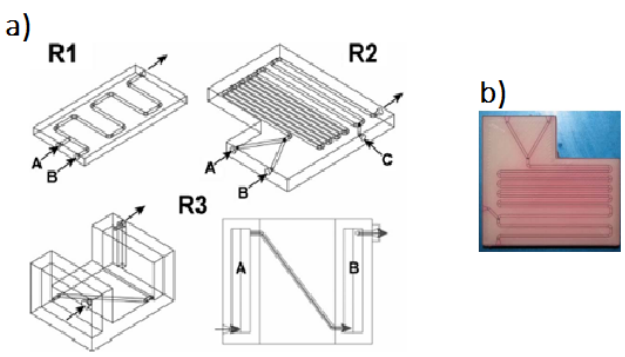
Figure 5. ( a ) CAD drawings of three devices: R1: Two ‐ inlet device. R2: Three ‐ inlet device. R3: Oblique and aerial view of a one ‐ inlet device with two “silos,” one filled with sodium molybdate (A) and the other filled with hydrazine dihydrochloride (B); ( b ) Three ‐ inlet device printed. In order to make its channels visible, they were filled with a methanol solution of rhodamine B dye (completely removable with washing). (Reproduced with permission from [17].)